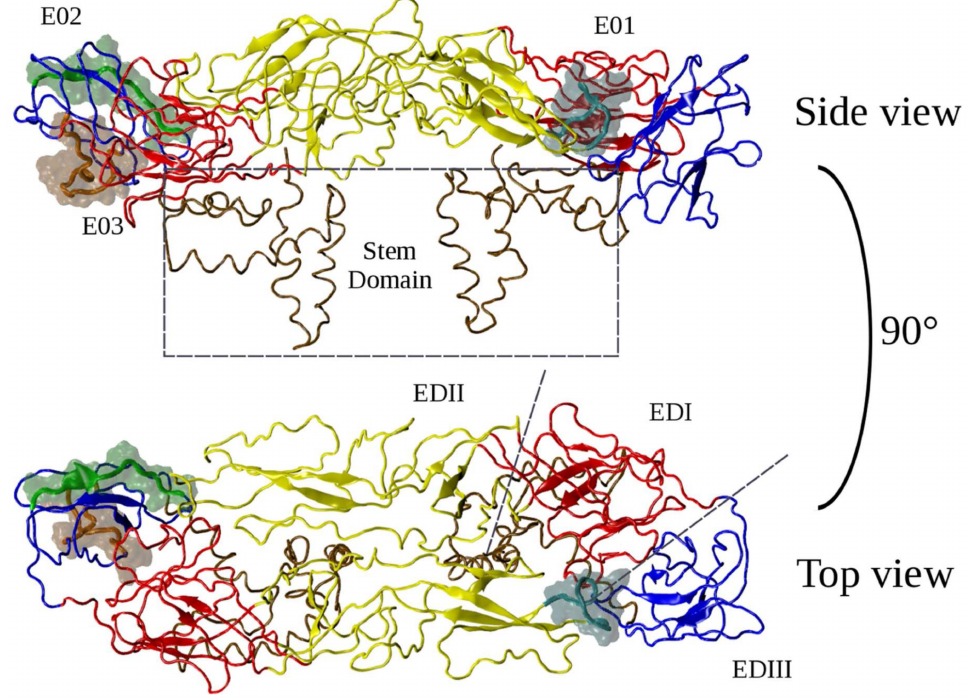
Figure 1. Structure of the envelope (E) protein and localization of the putative epitopes E01, E02,